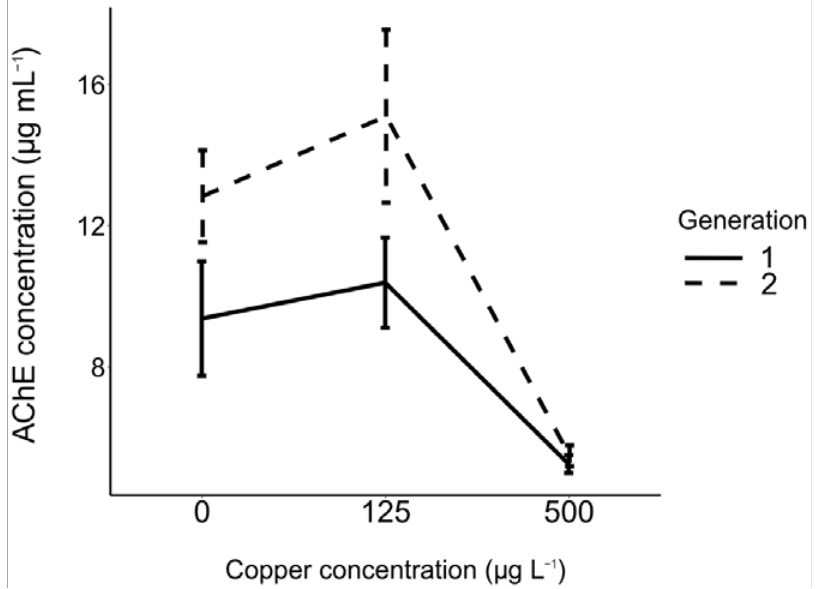
Figure 3. Effect of different concentrations of copper exposure (0, 125 and 500 µ g L −1 ) on acetylcho-